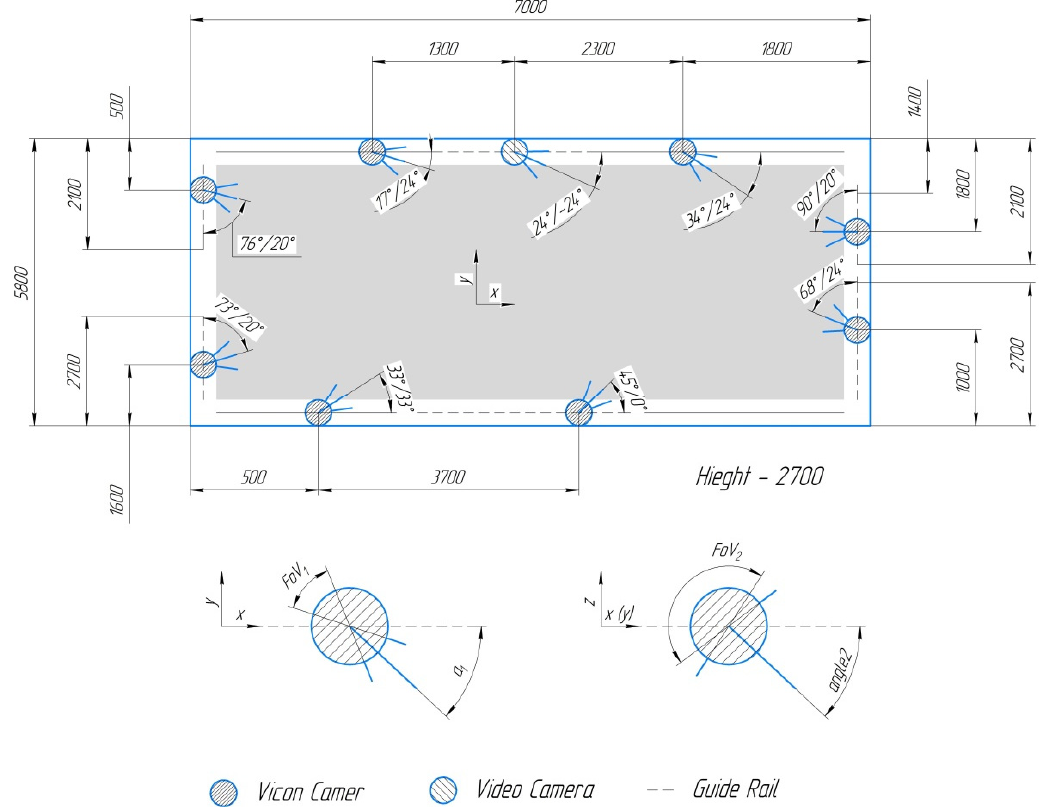
Figure 1. Arrangement of cameras on the working area.